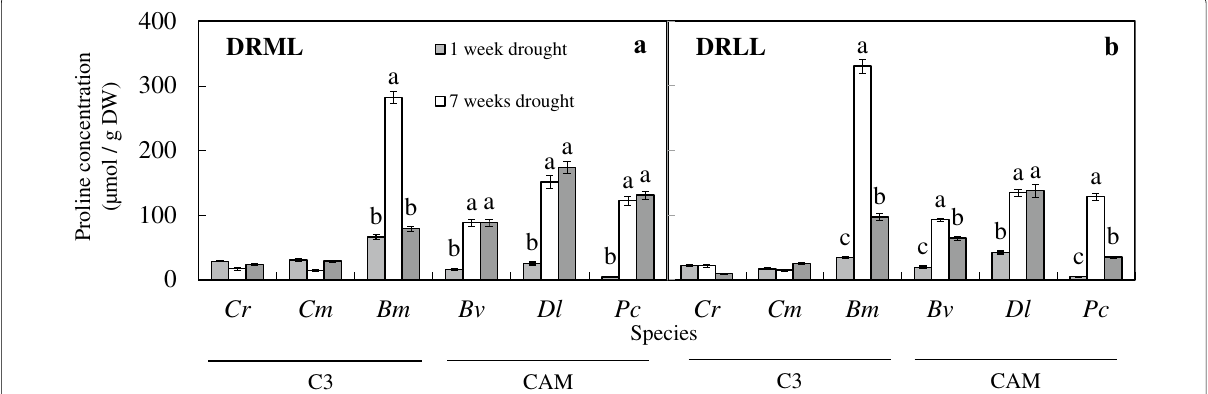
Fig. 7 Changes in proline concentration in the leaves of C. rochussenii ( Cr ), C. mayeriana ( Cm ), B. membranaceum ( Bm ), B. vaginatum ( Bv ), D. leonis ( Dl ) and P. cornu - cervi ( Pc ) after 1 and 7 weeks of drought and after 14 weeks of re-watering under moderate light ( a ) and low light ( b ). Vertical bars represent standard error. Different letters above bars indicate statistical difference (Tukey’s multiple comparison, p < 0.05, n